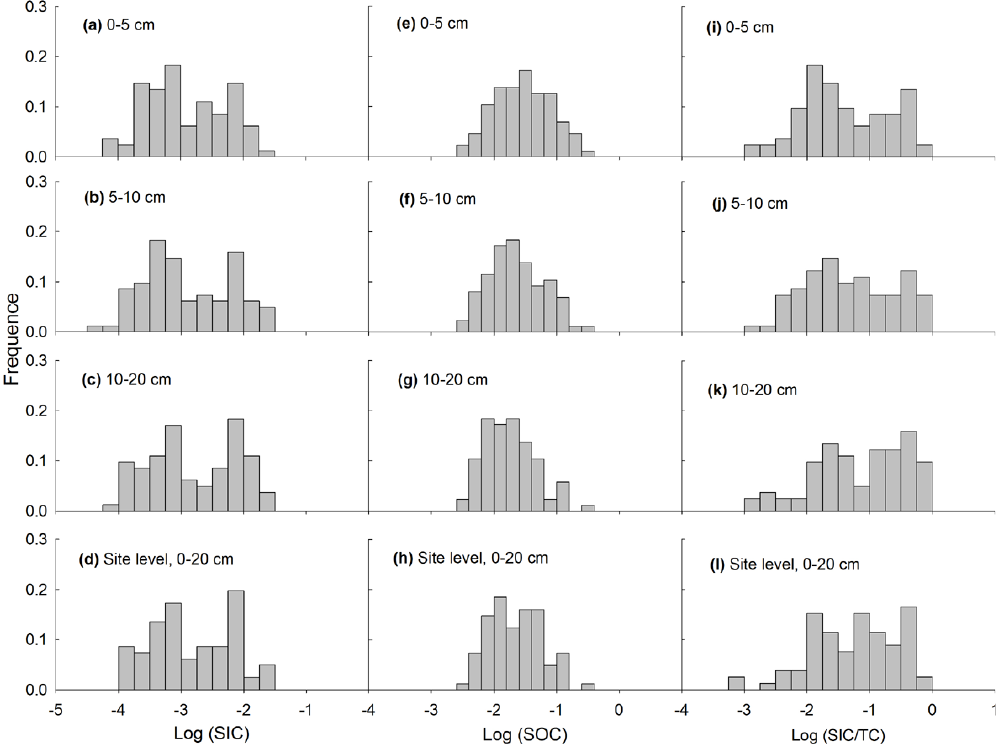
Fig. 2. Frequency distributions of SIC (a–d) , SOC (e–h) and SIC/STC (i–l) in Chinese grasslands across all sampling sites at soil depths of 0–5cm (a, e, i) , 5–10cm (b, f, j) , 10–20cm (c, g, k) and at site level (d, h, l) . All distributions have no significant differences compared with normal distribution at P < 0 .